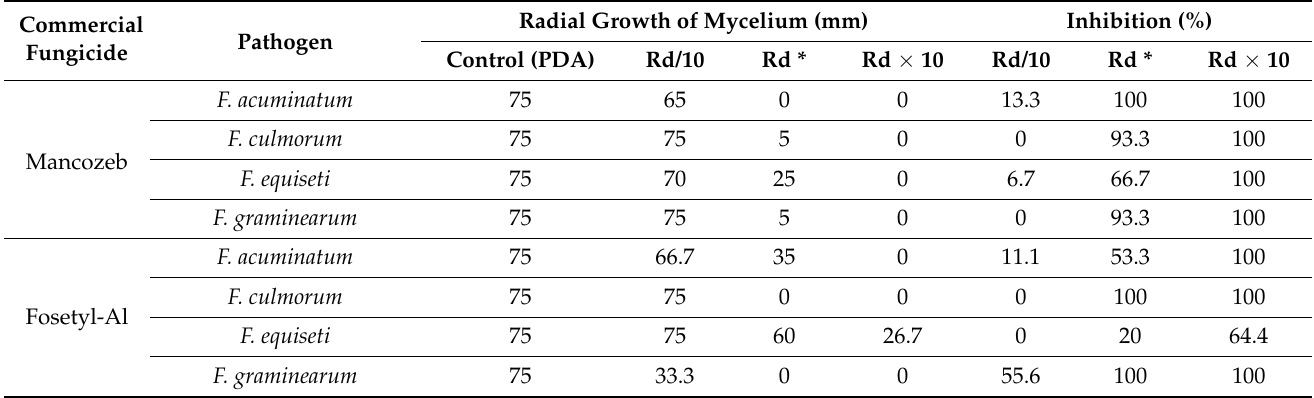
Table 4. Radial growth of the mycelium of F. acuminatum , F. culmorum , F. equiseti , and F. graminearum in the in vitro assays performed on a PDA medium with different concentrations of two commercial synthetic fungicides, namely a tenth of the recommended dose (Rd/10), the recommended dose (Rd), and ten times the recommended dose (Rd × 10).